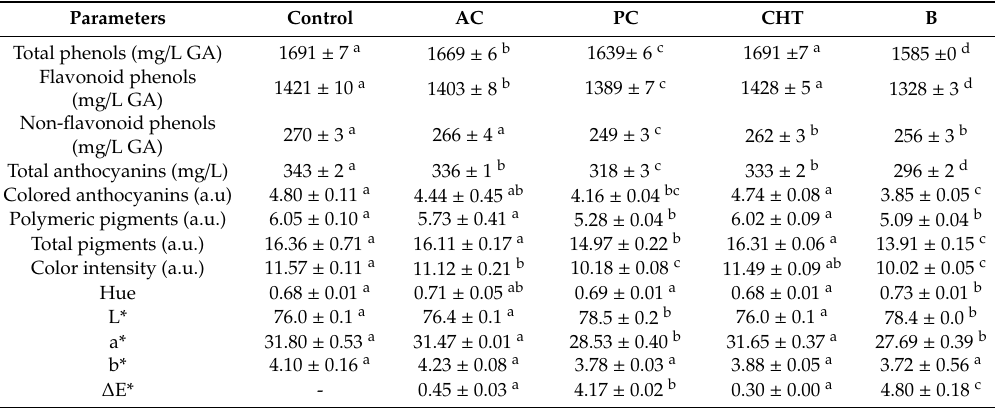
Table 3. E ff ect of fining agents’ application on phenolic compounds and chromatic characteristics of red